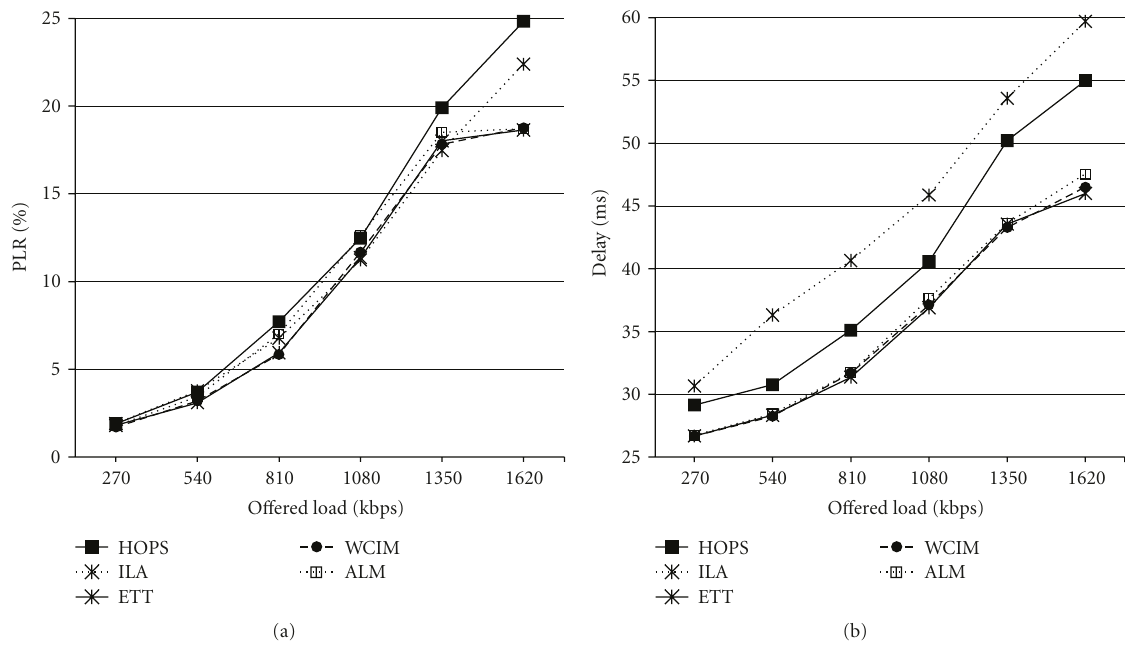
Figure 8: Scenario 3 results. (a) Packet loss rate. (b) End-to-end